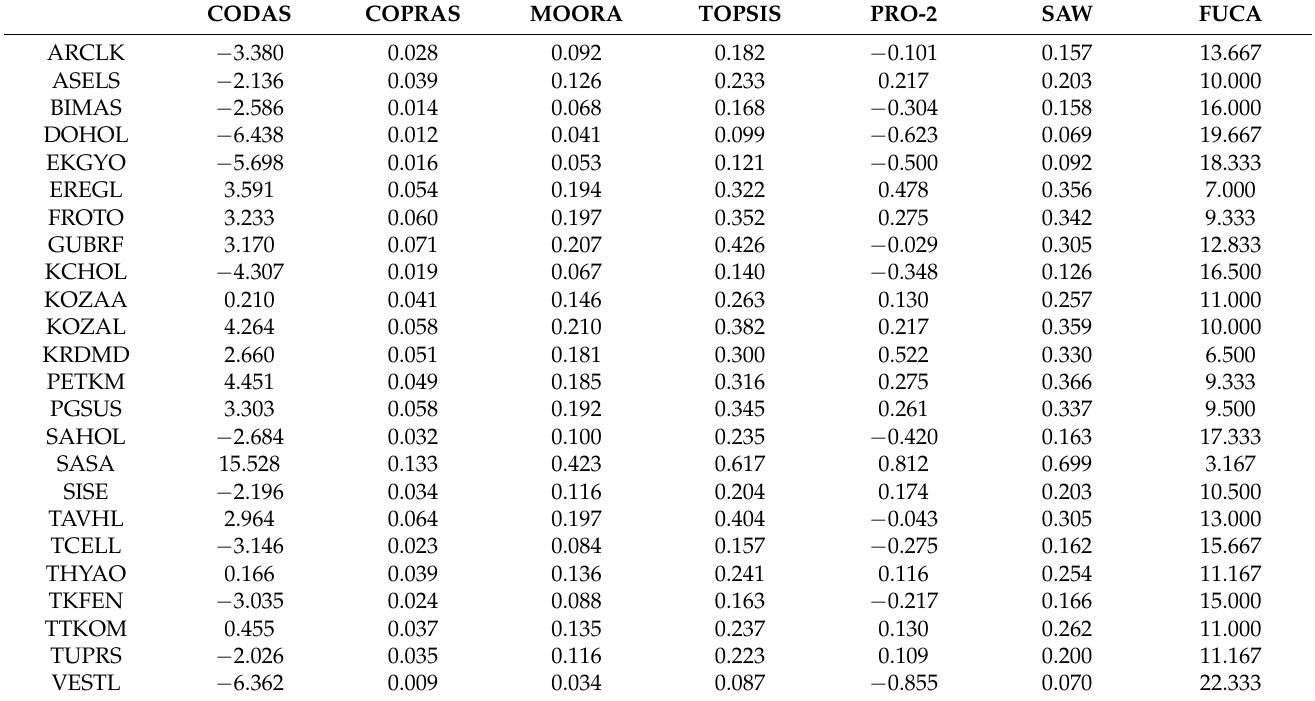
Table 6. Final Score Results Produced by MCDM Methods (for the 2021/09).